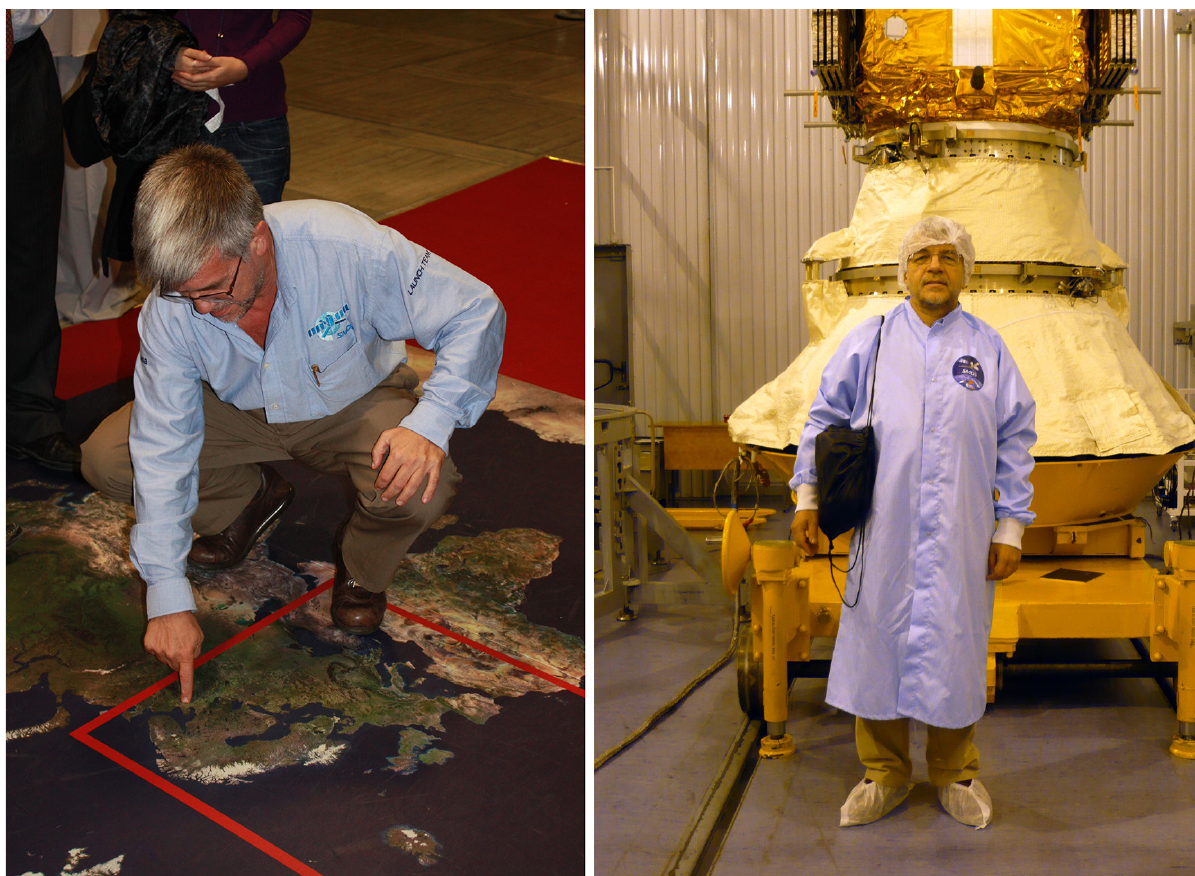
Fig. 4. – (Left panel) Jordi Font during a press event in Barcelona in November 2009, a few days before launching the SMOS. (Right panel) Jordi with the ROCKOT behind, carrying the SMOS satellite, ready to be launched at Plesetsk, in northern Russia, in